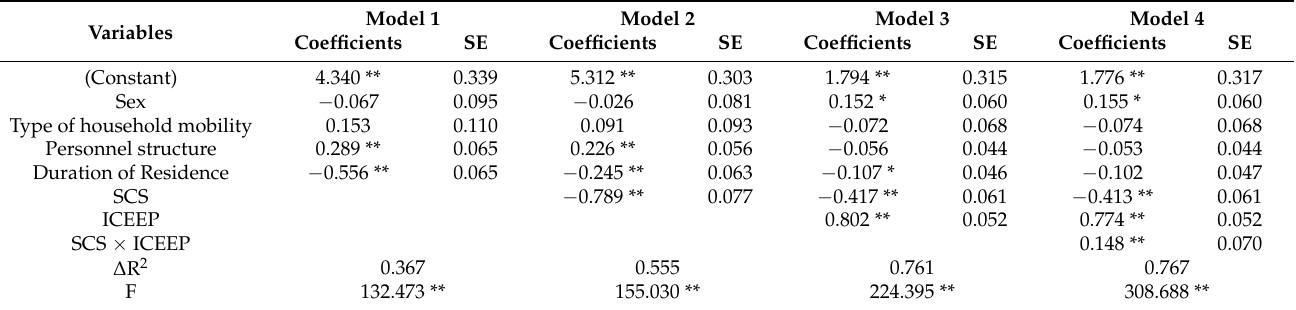
Table 3. Moderating effect of ICEEP on the relationship between SCS and